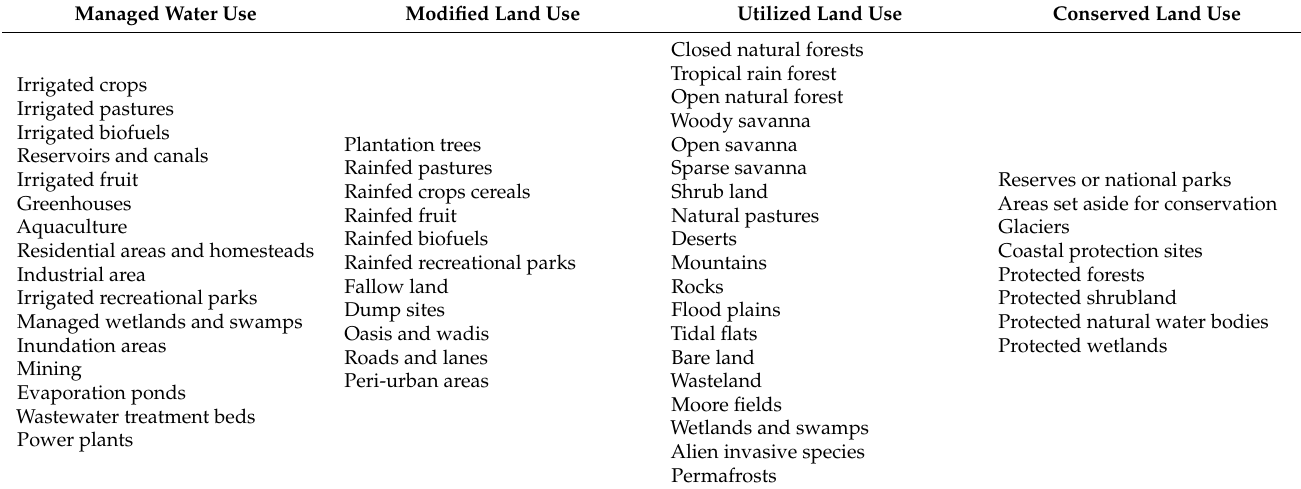
Table 2. Land use class categories with a likeness to ecosystem services, human interaction, provi- sioning services, and interventions in the water cycle. These classes govern the management options in